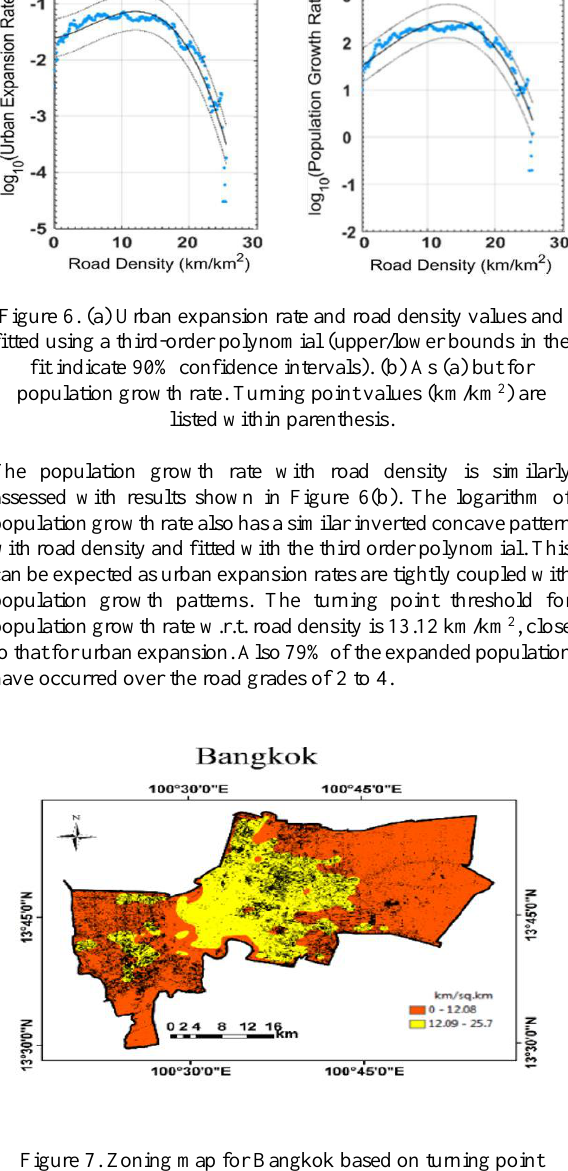
Figure 7. Zoning map for Bangkok based on turning point threshold. Overlaid black pixels indicate urban expanded areas.